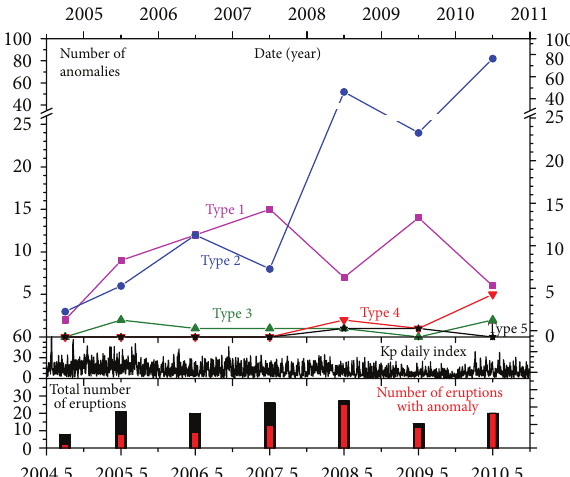
Figure 4: Top: number of the 5 types of anomalies per year between mid-2004 and December 2010. Middle: daily mean Kp index versus time. Bottom: bar chart of the number of eruptions having given rise to ionospheric anomalies (red) or not